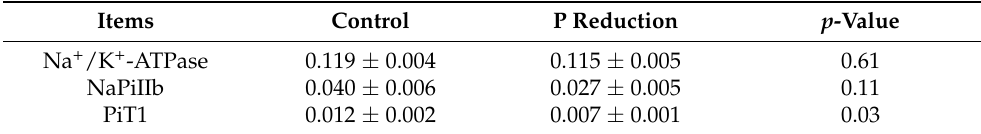
Table 8. Relative amounts of Na + /K + -ATPase, NaPiIIb and PiT1 protein expression normalised to total protein amounts in the ileum of goats fed a phosphorus (P) reduced diet. (Mean values with their standard errors; n = 7